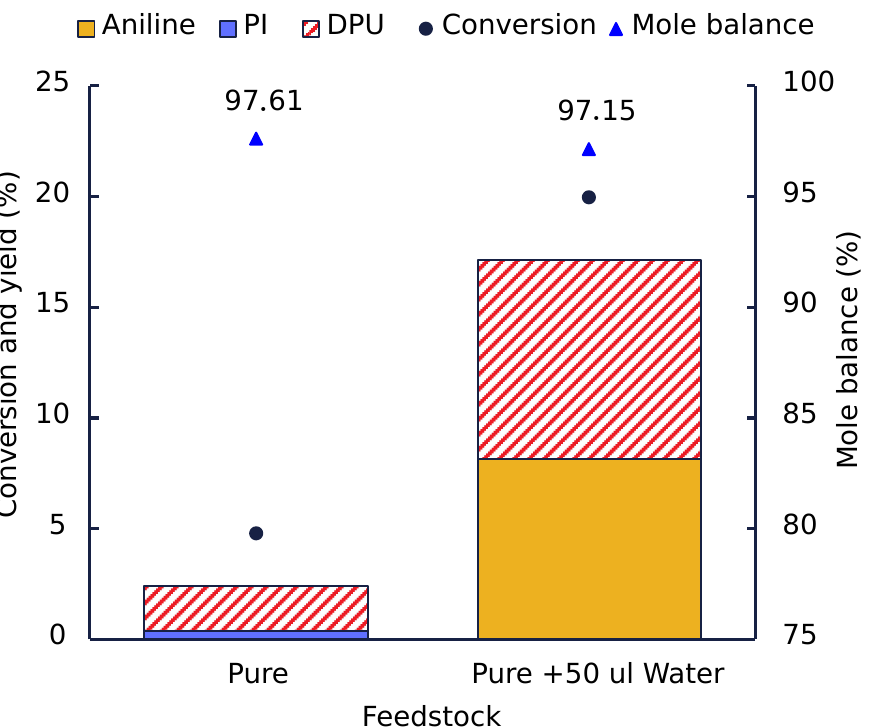
Figure 6. Effect of water addition (stoichiometric amount) in the thermal cleavage of